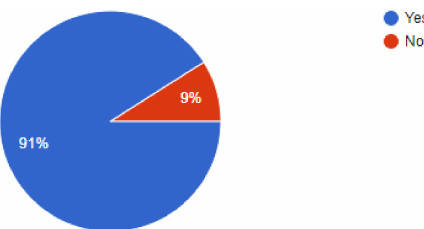
Figure 11. Do you strictly implement the 1-meter distance for seating patients in your clinic?